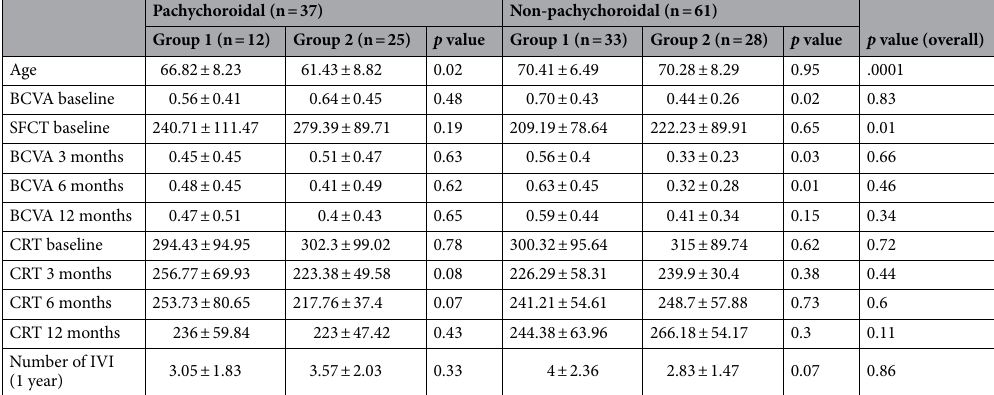
Table 3. Therapeutic effects in PCV with varied choroidal thickness. Values are presented as the mean ± standard deviation. Group 1 intravitreal injection of ranibizumab + photodynamic therapy, Group 2 intravitreal injection of aflibercept alone, BCVA best-corrected visual acuity, CRT central retinal thickness, IVI intravitreal injection, PCV polypoidal choroidal